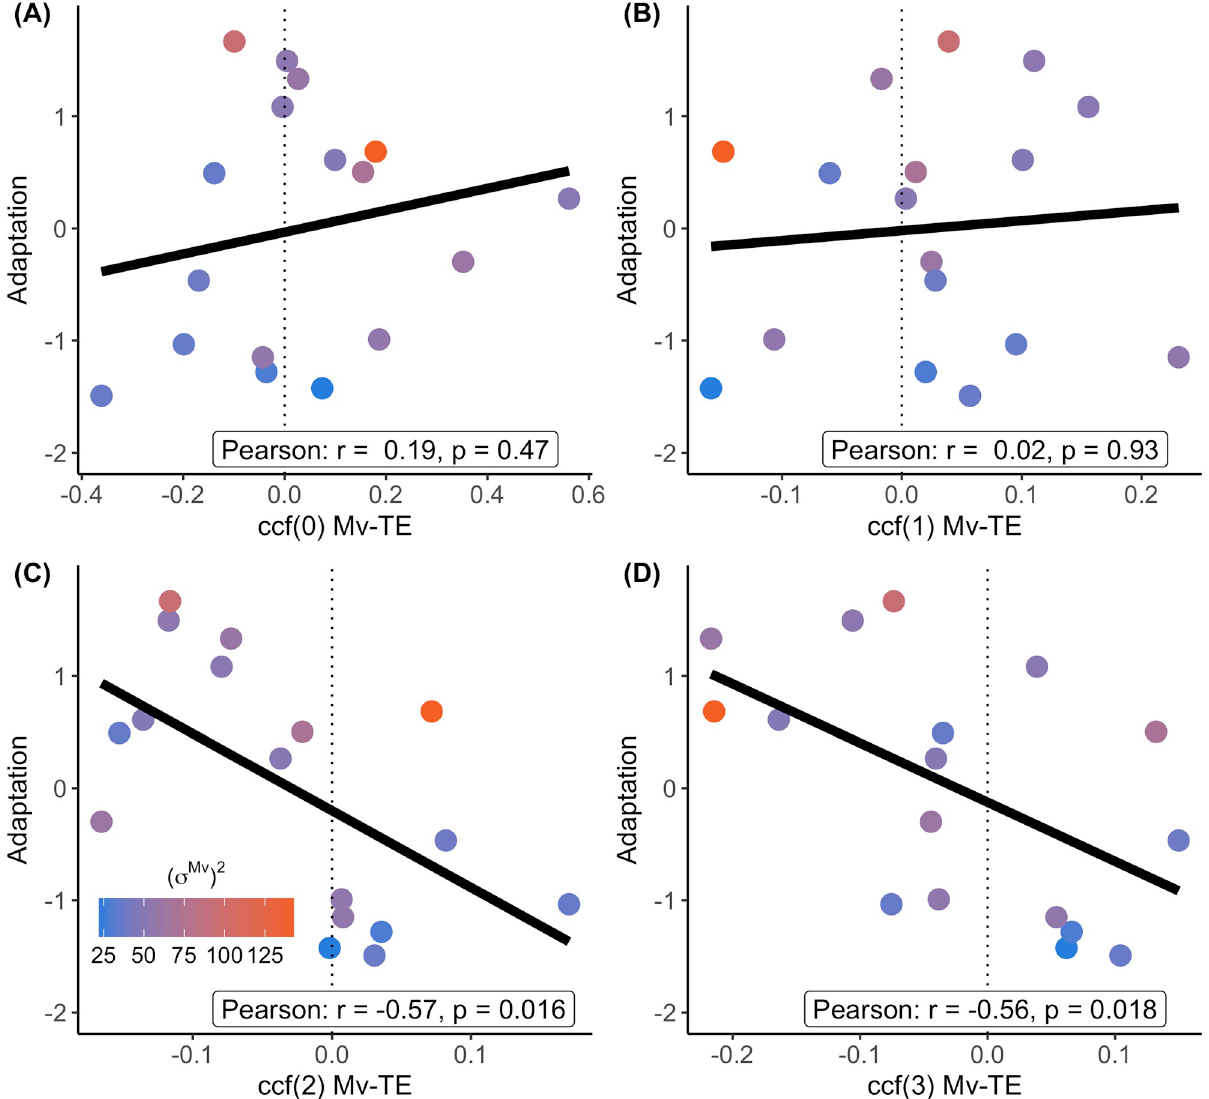
Fig 7. The relationship between the ccf score and the adaptation score. The ccf is shown for lags 0-3 (A-D). The color of the data-points (blue- orange) indicates the size of the ( σ Mv ) 2 . The dotted line indicates a ccf of zero.